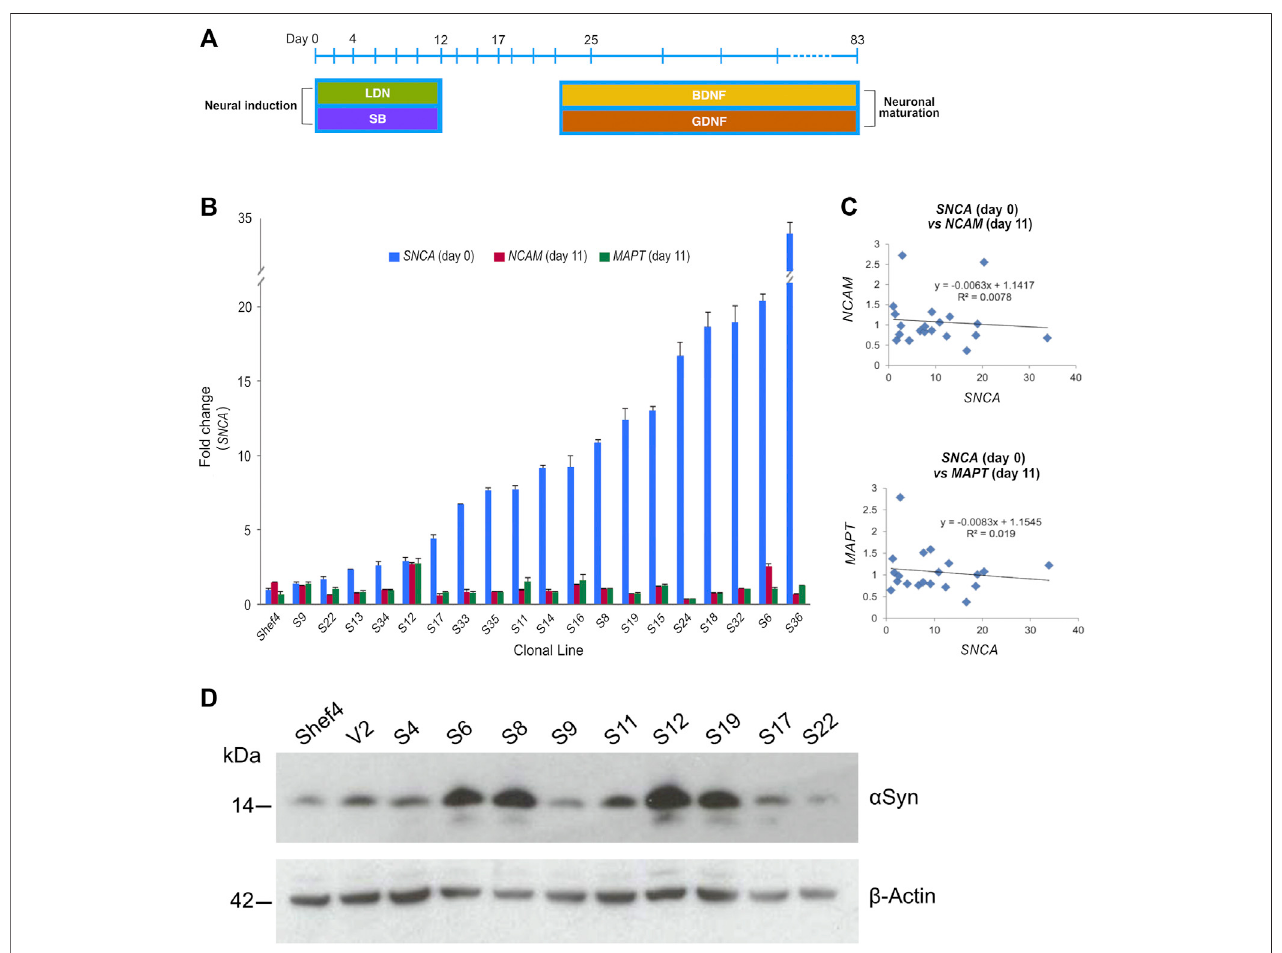
FIGURE 2 | Level of α Syn does not impair neural induction. (A) Schematic summarising key stages of the cortical neuron differentiation protocol. Cell lifts were carriedoutatdays12,17,and25.DualSMADinhibitionusingSB431542(SB)andLDN-193189(LDN)wasemployedearlytodriveneuralinductionandcorticalidentity, and the growth factors BDNF and GDNF were used to promote neuronal maturation after day 25. (B) Quantitative RT-PCR data measuring total SNCA expression in undifferentiatedtransgenic Shef4cell lines,and NCAM and MAPT mRNA levels at day 11 ofdifferentiation. Datashown asrelative fold-changeto expression in the parental Shef4 line, and error bars represent the standard error of the mean (SEM). (C) Linear regression analysis of SNCA , NCAM , and MAPT expression levels was performed( p =0.174and p =0.191for NCAM and MAPT ,respectively). (D) Westernblotfor α Synand ß -actinofwholecelllysatesfromcorticalneuroectoderm(day11) differentiated from transgenic hESC